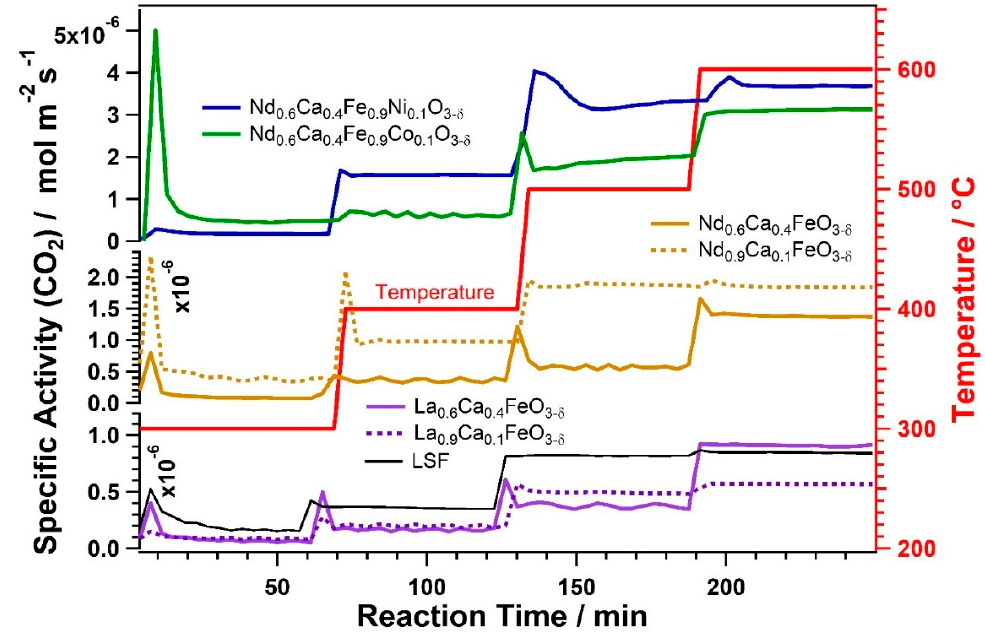
Figure 4. Comparison of HT-WGS activity of the novel perovskites. For this, the CO 2 formation rate is given as surface specific activity in mol m − 2 s − 1 . For comparison, the reactivity of LSF is shown as well (black line). The reaction environment consisted of a 1:1 mixture of H 2 O and CO, and temperature was increased gradually from 300 to 600 ◦ C. The Co- and Ni-doped perovskites were the most active materials at the highest reaction temperature.